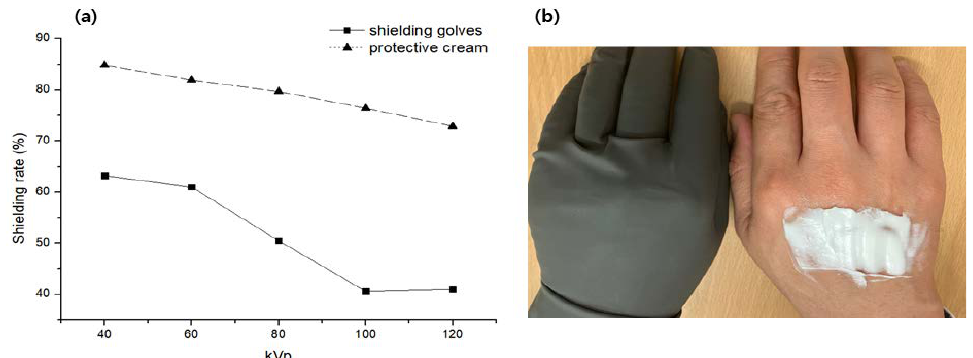
Figure 6. Comparison of shielding gloves and protective cream (30 wt%); ( a ) tungsten-based surgical shielding gloves (0.45 mm), and ( b ) barium sulfate-based protective cream (3.0 mm).